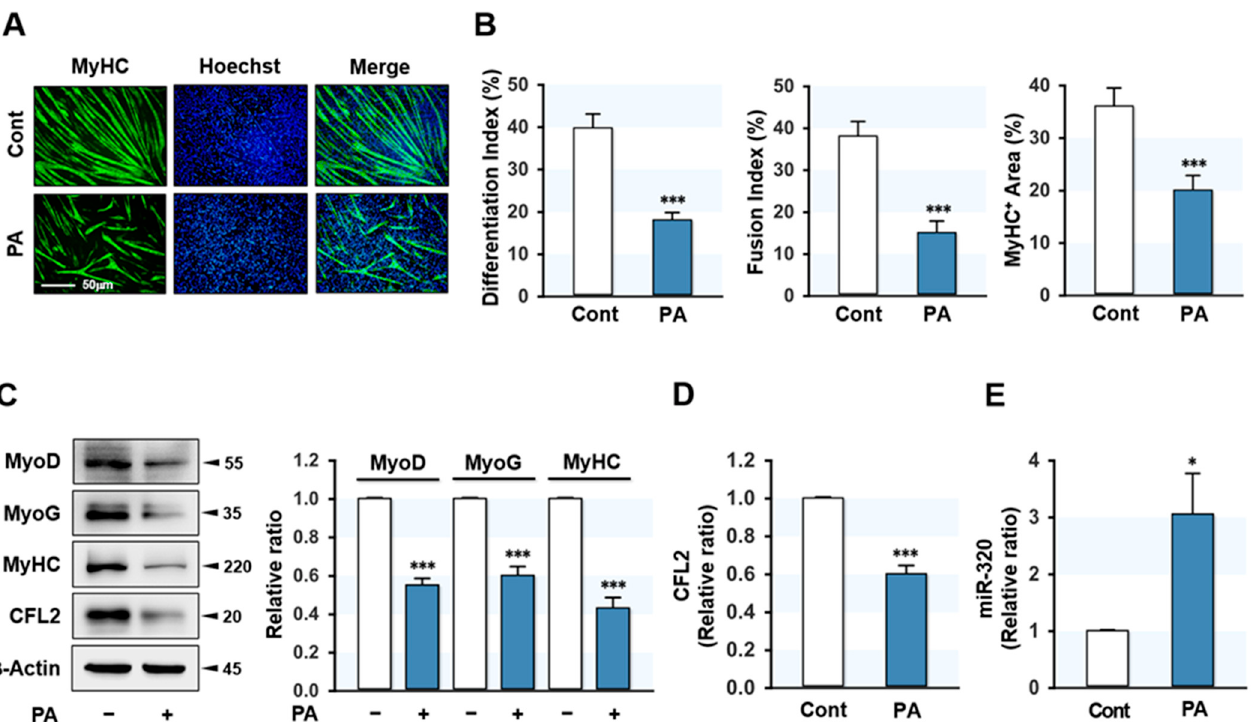
Figure 1. Effect of PA on myoblast differentiation and miR-320-3p expression. C2C12 cells were treated with BSA (Cont) or BSA-conjugated PA (PA, 100 μ M) for 24 h and induced differentiation. ( A ) Immunocytochemical staining of MyHC (green) at day 5 of differentiation. Nuclei were stained with Hoechst 33342 (blue). Scale bar, 50 μ m. ( B ) MyHC-positive area, differentiation index, and fusion index were quantitated with ImageJ software. ( C , D ) The expressions of myogenic regulatory factors (MyoG and MyoD), MyHC, and CFL2 were analyzed by immunoblotting at day 3 of differentiation. The values between panels indicate relative protein levels normalized against β -Actin. ( E ) The mRNA levels of miR-320-3p were measured by q RT-PCR 24 h after transfection and normalized against U6. Results are means ± SEMs ( n > 3). *, p < 0.05; ***, p < 0.001 vs. control.